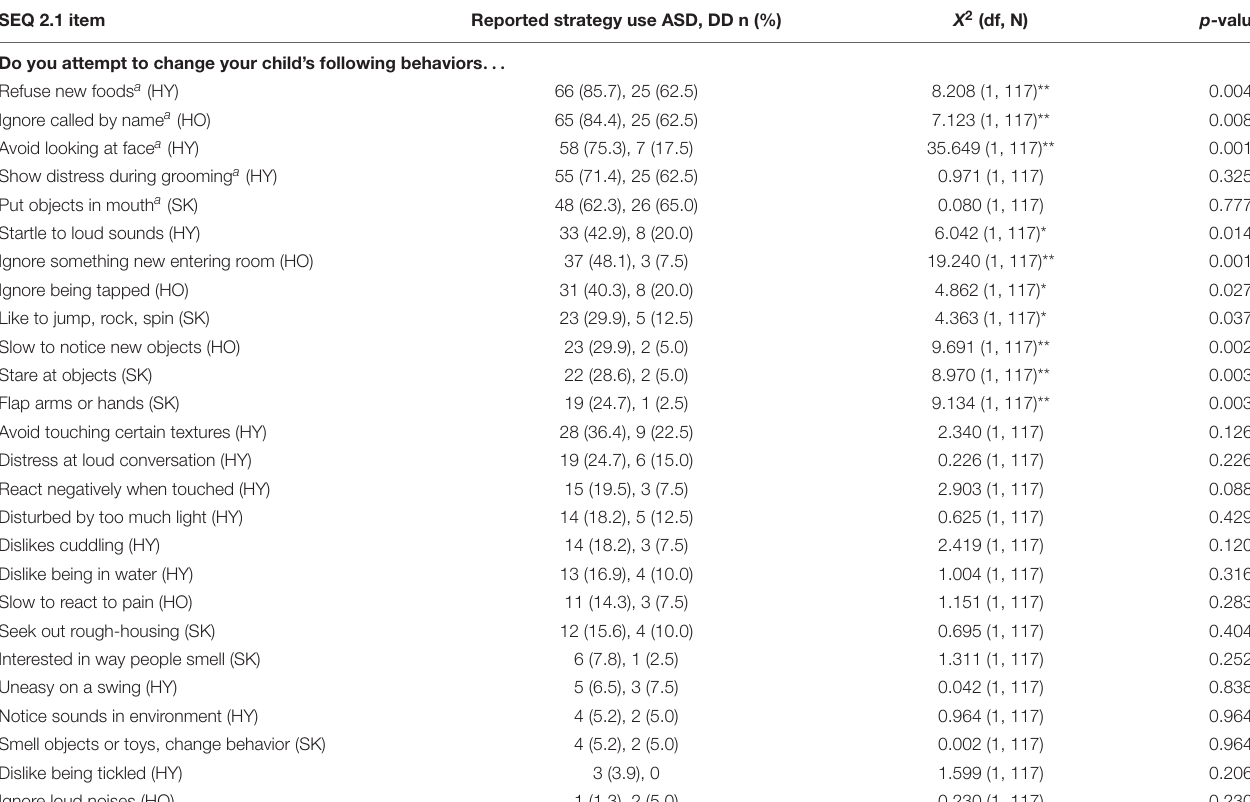
TABLE 3 | Item level results. SEQ 2.1